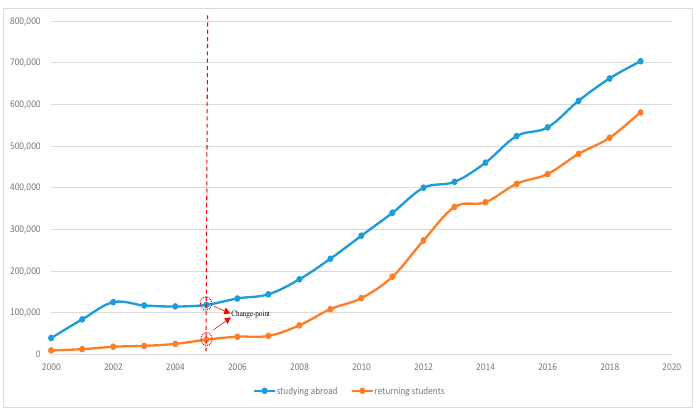
Figure 2. Historical annual number of Chinese students studying abroad and returned students (unit: person).